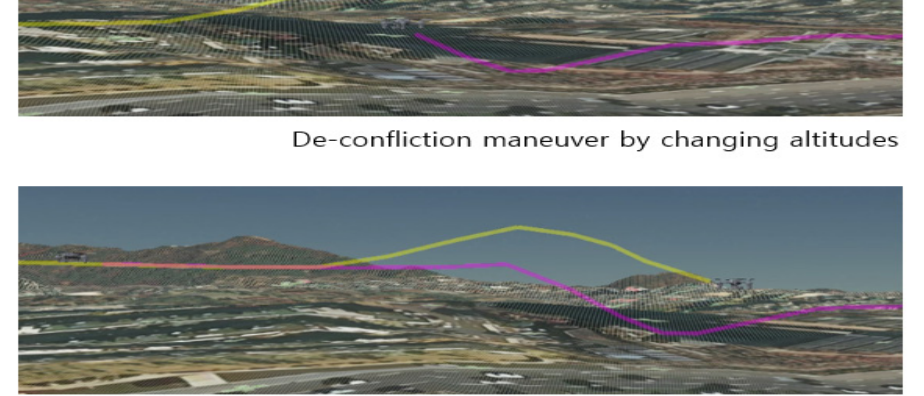
Figure 16. Scenario #4 (geofence avoidance).